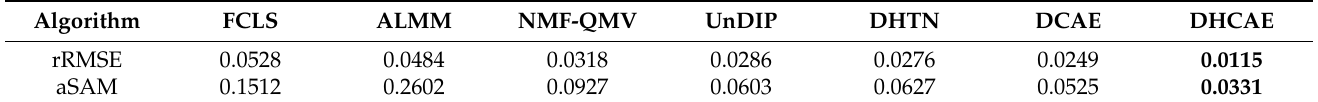
Figure 11. Hyperspectral dataset. ( a ) Urban. ( b ) Band 138. ( c ) Band 149. ( d ) Band 208. ( e ) Band 209.